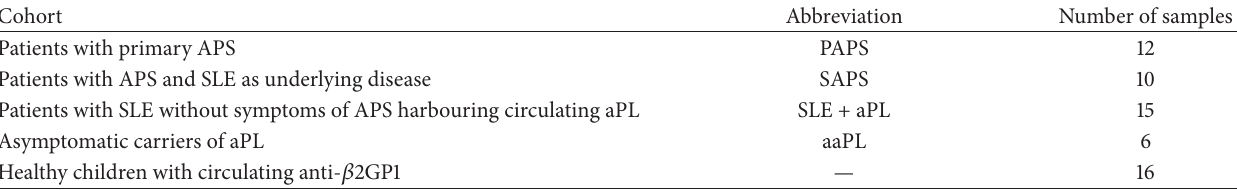
Table 5: Cohorts studied with the lectin